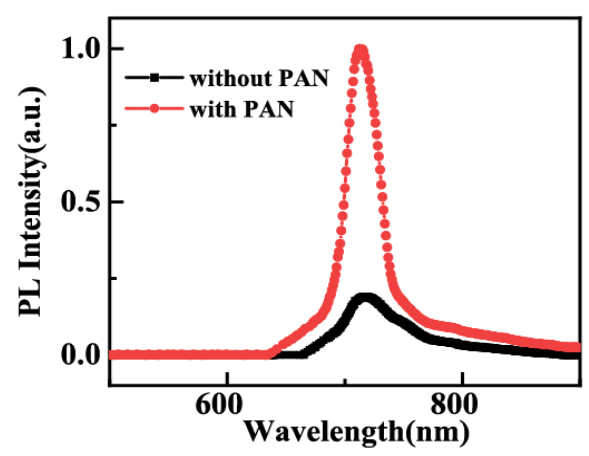
Figure 4. Photoluminescence spectra of the CsPbBr 2.5 I 0.5 Figure 4 . Photoluminescence spectra of the CsPbBr 2.5 I 0.5 film . Figure 4 . Photoluminescence spectra of the CsPbBr 2.5 I 0.5 film .